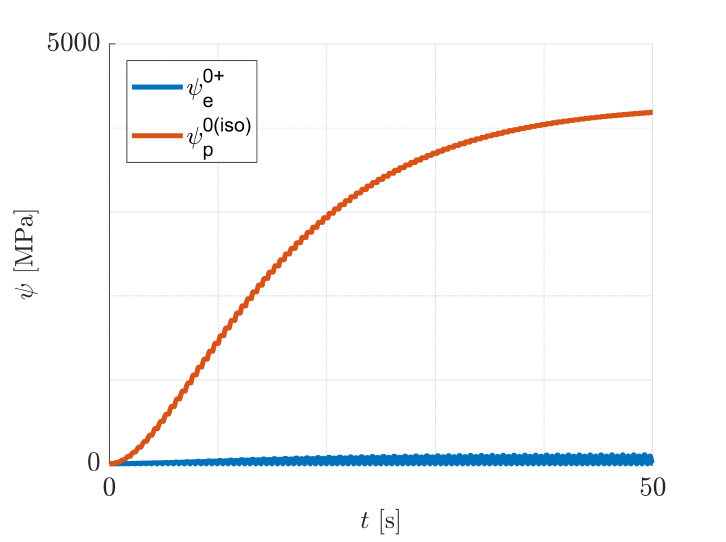
( iso ) = p with time t for ε 0